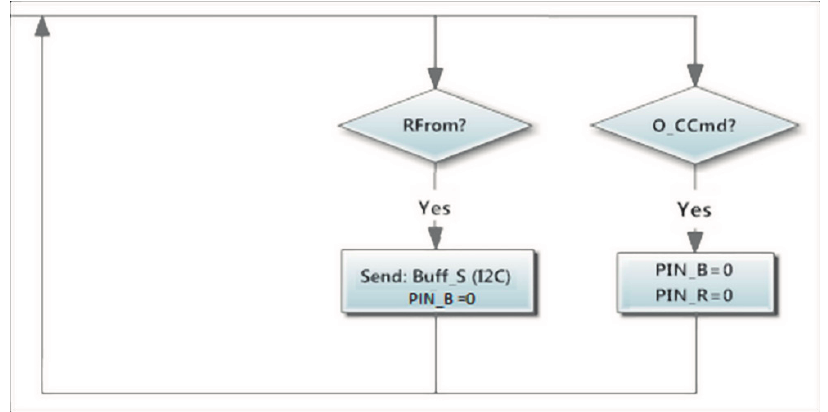
Figure 6. Wireless module, I 2 C Support Orders.